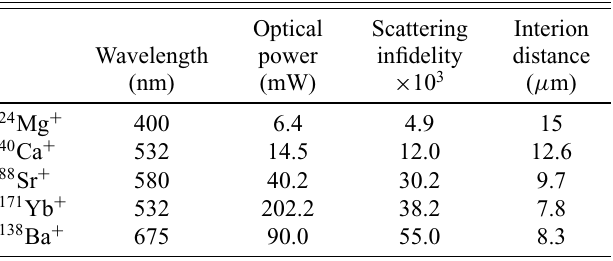
TABLE I. Tweezer parameters and scattering-induced infi- delity for ground-state qubit encoding in different ionic species. The parameters (cid:14) = 0.07, ν 0 = 0.4, and ω x = 2 π × 3 MHz are fixed for all species, and the numerical aperture is assumed to be 0.7 (see Appendix B for details). The tweezer wavelength is cho- sen to result in a close-to-optimal scattering infidelity while being experimentally accessible in terms of both power per tweezer spot in the second column and available laser sources. Optical Scattering Interion Wavelength power infidelity distance × 10 3 (nm) (mW) ( μ m)